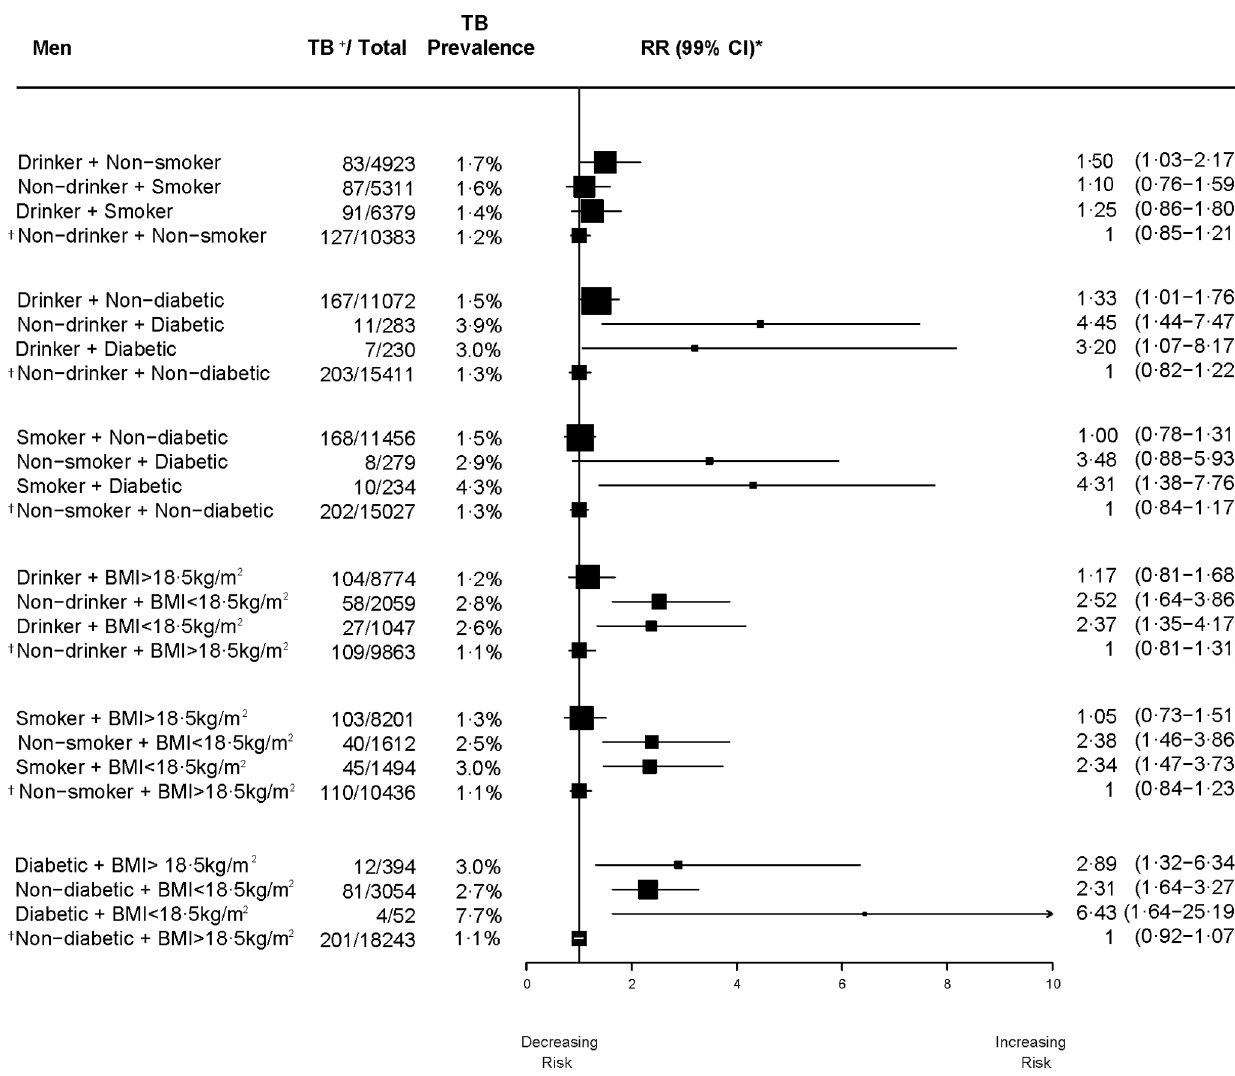
Figure 2. Independent and joint effects of risk factors on self-reported symptoms of active TB disease, 18–54 years in men.